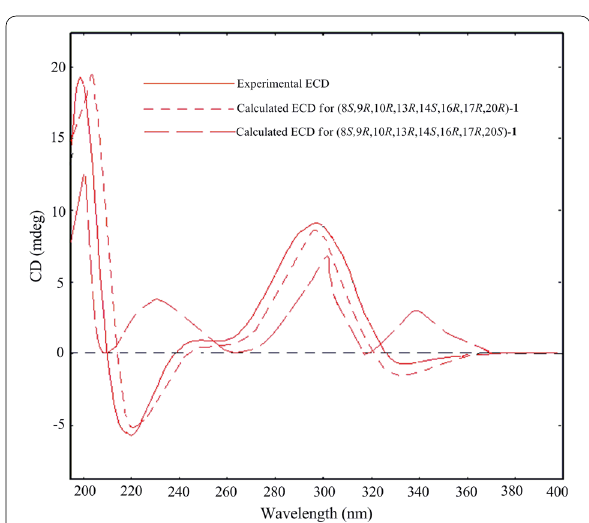
Fig. 4 Experimental and calculated ECD spectra for compound 1